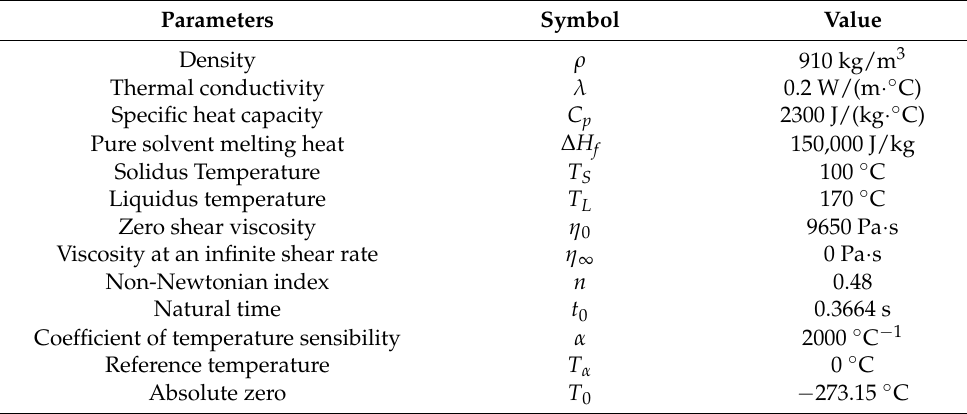
Table 2. Material properties of polypropylene.